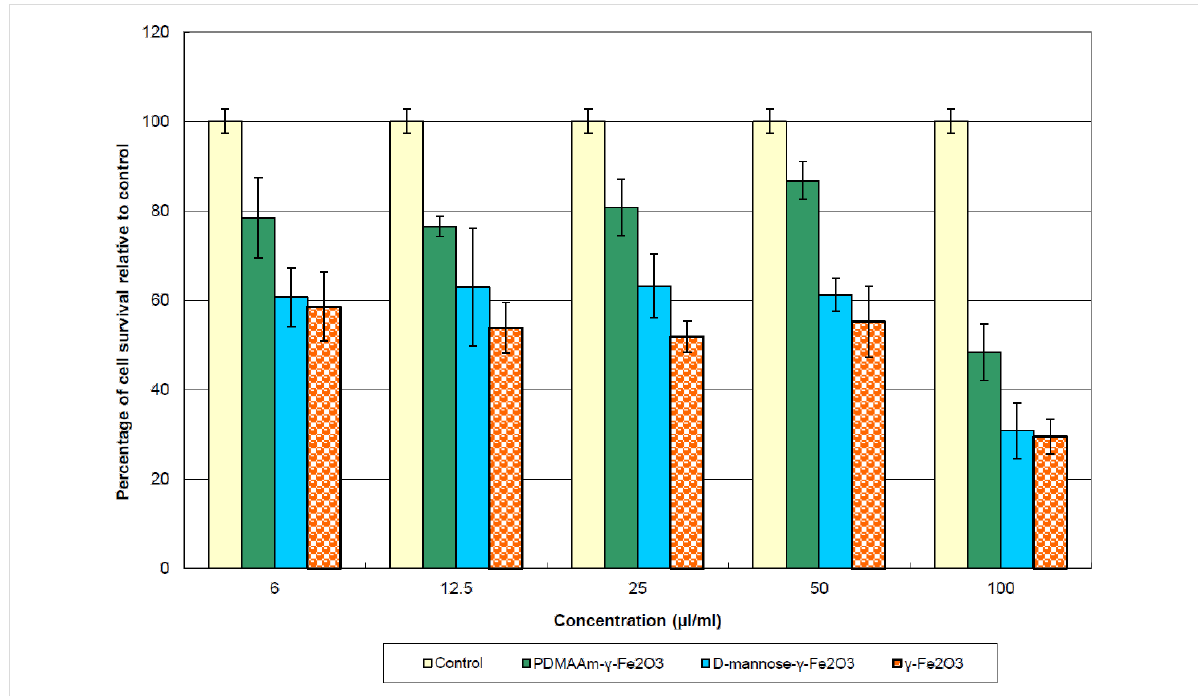
Figure 2: Effect of non-coated, D-mannose- and PDMAAm-coated γ -Fe 2 O 3 on the in vitro survival of 4BL human cells at different concentrations of particles in the medium.